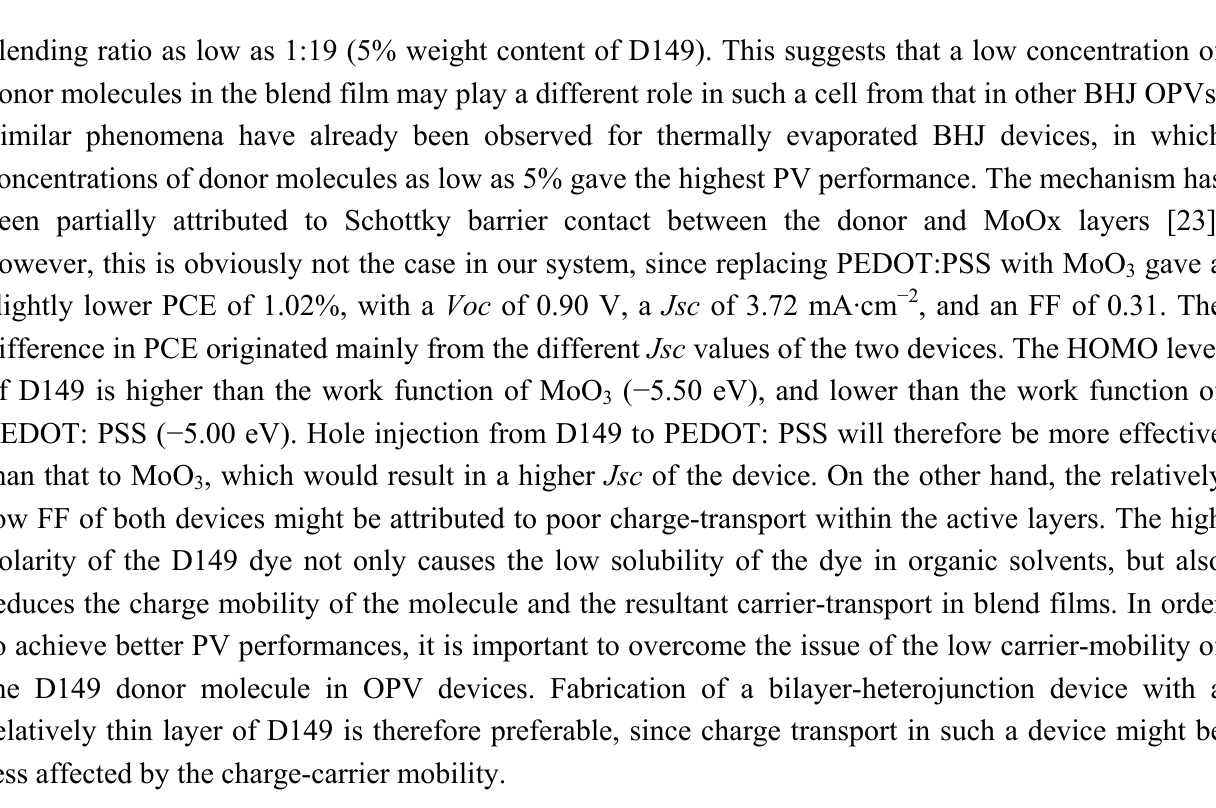
Table 1. Performance details of the photovoltaic devices sharing a structure of ITO/PEDOT: PSS/D149:PC BM/BCP/Al, varying the blending ratios (w/w) of 70